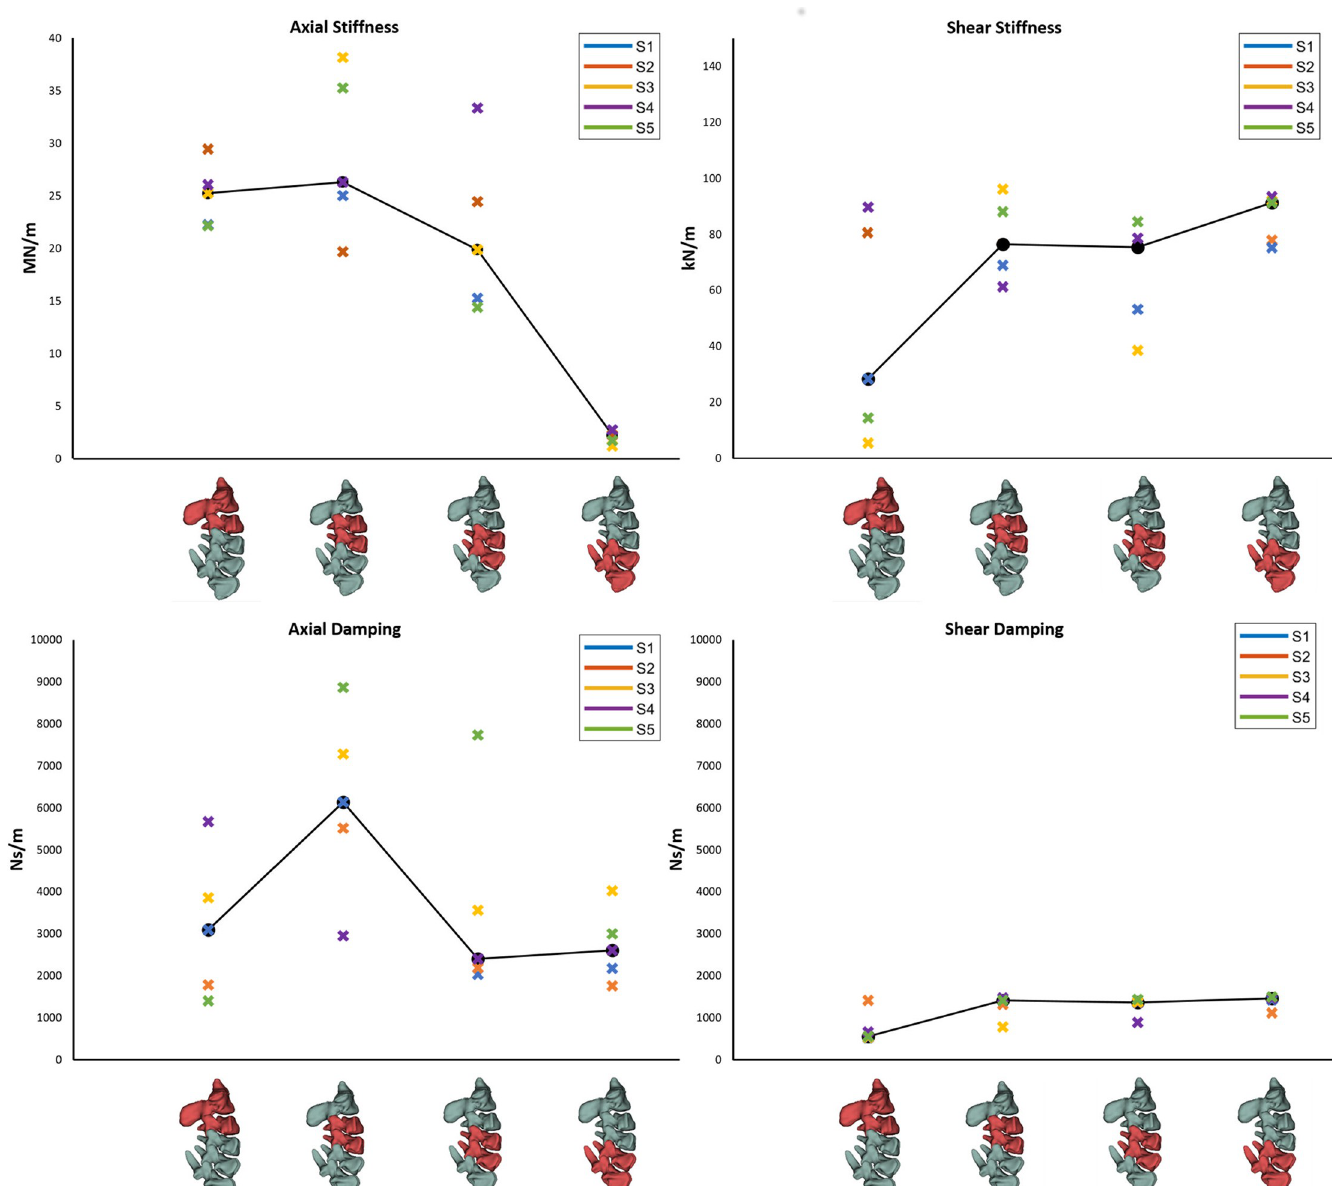
Fig 5. Parameter values identified by the optimisation procedure. Axial stiffness (top left), shear stiffness (top right), axial damping (bottom left) and shear damping (bottom right). Values are shown for each of the cervical spine joints identified by the two red coloured vertebrae on the horizontal axis and for each of the five specimens identified by the